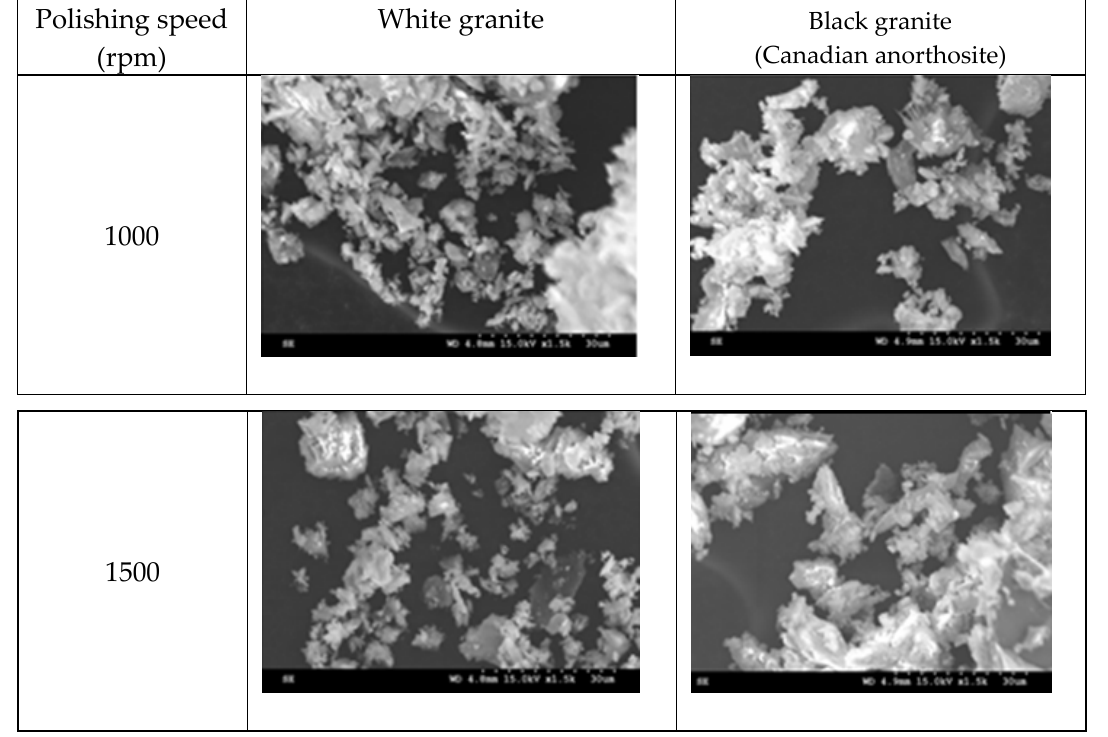
Figure 8. SEM images of particles obtained when polishing white and Canadian anorthosite at different speeds (feed rate—508 mm/min; grit size—60; pressure—0.2 bar).